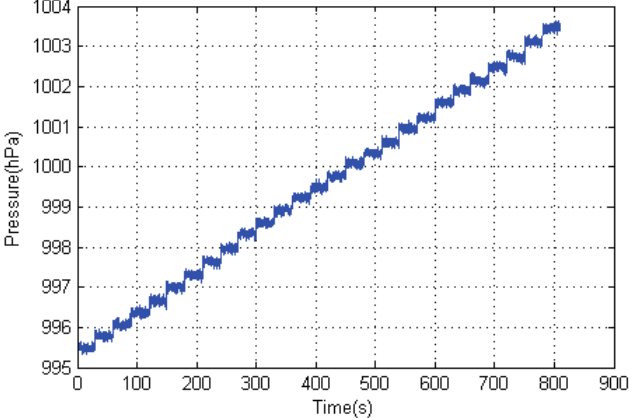
Figure 1. Barometric-pressure distribution of a 25-story building (with two